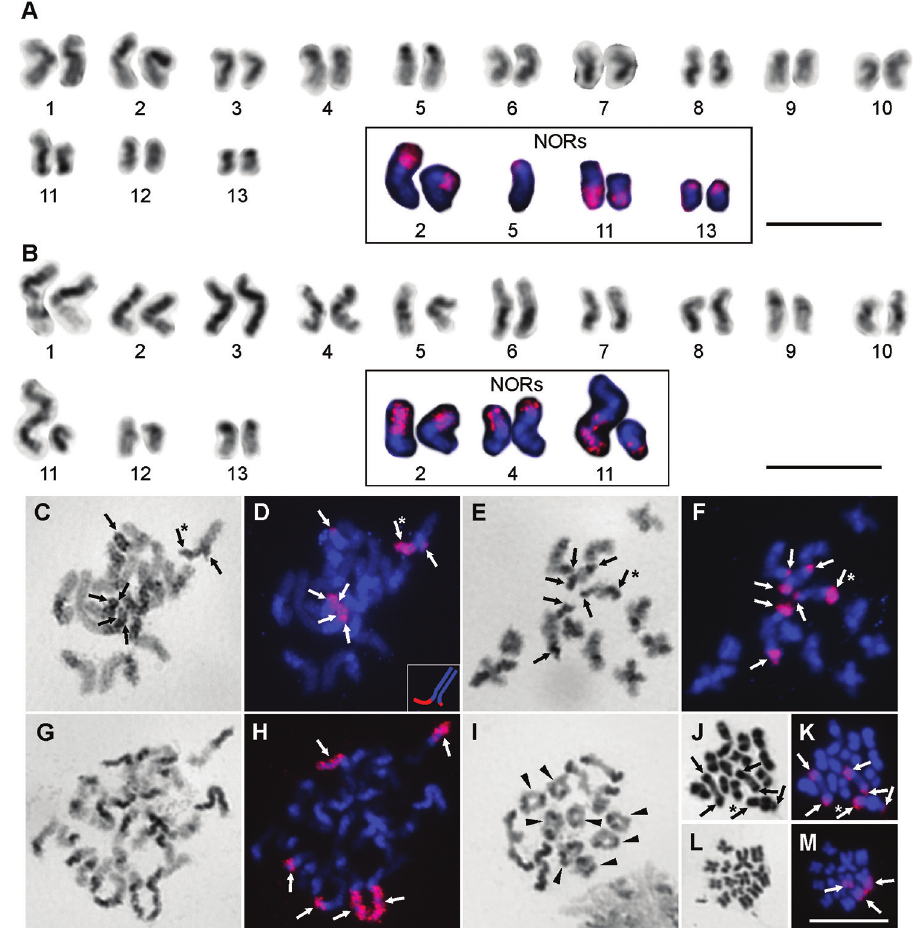
Figure 3. Chromosomes of Rhampsinitus leighi (2n=26) from Vernon Crookes ( A, C–F ) and from Silaka ( B, G–M ) after Giemsa staining ( A–C, E, G, I, J, L ) and after FISH with 18S rDNA ( A and B partly, D, F, H, K, M ). A, B karyotypes of males based on mitotic metaphase C, D pachytene with heterozygous bivalent (asterisk), bottom right inset shows a reconstruction of the heteromorphic bivalent E, F diplotene with heterozygous bivalent (asterisk) G, H mitotic prophase I diplotene, arrowheads indicate bivalents with two chiasmata. J, K diakinesis L, M one sister cell of metaphase II. White arrows indicate the posi- tion of 18S rDNA and black arrows indicate the same position after Giemsa staining. Asterisks indicate heteromorphic bivalent with large signal of rDNA. Bar = 10